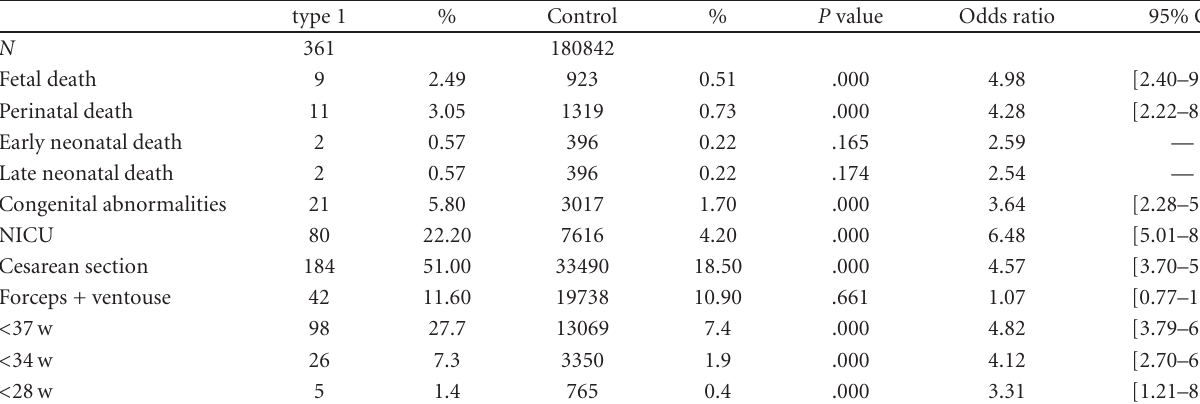
Table 2: Fetal-neonatal outcome.